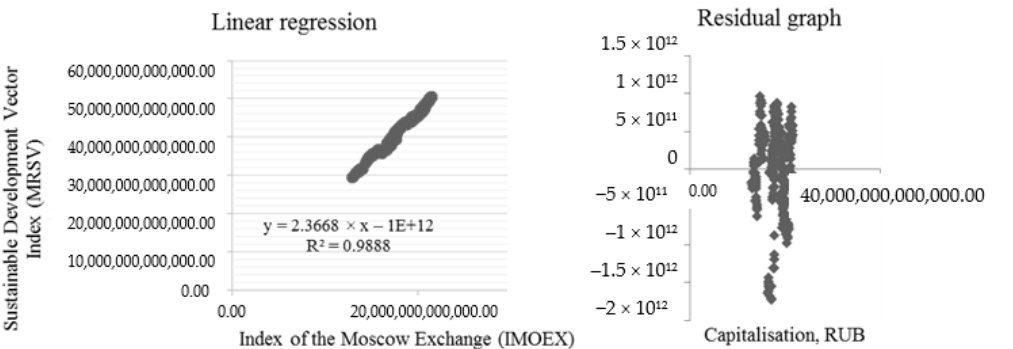
Figure 8. Residual graphs. Source: Obtained by the authors automatically with the help of the “Regression” function in Microsoft Excel.